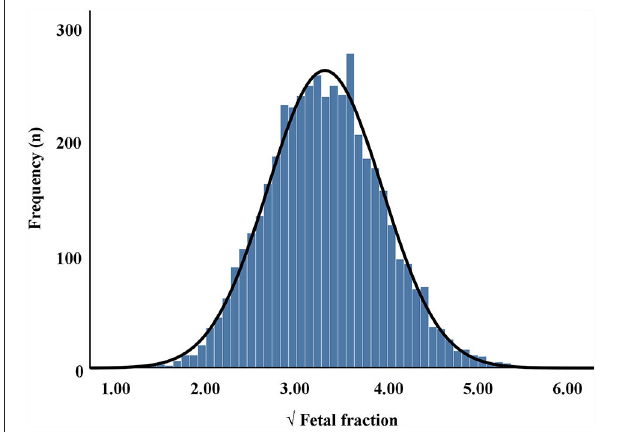
FIGURE 1 | Frequency distribution of square root ( √ ) of fetal fraction in maternal plasma cell-free